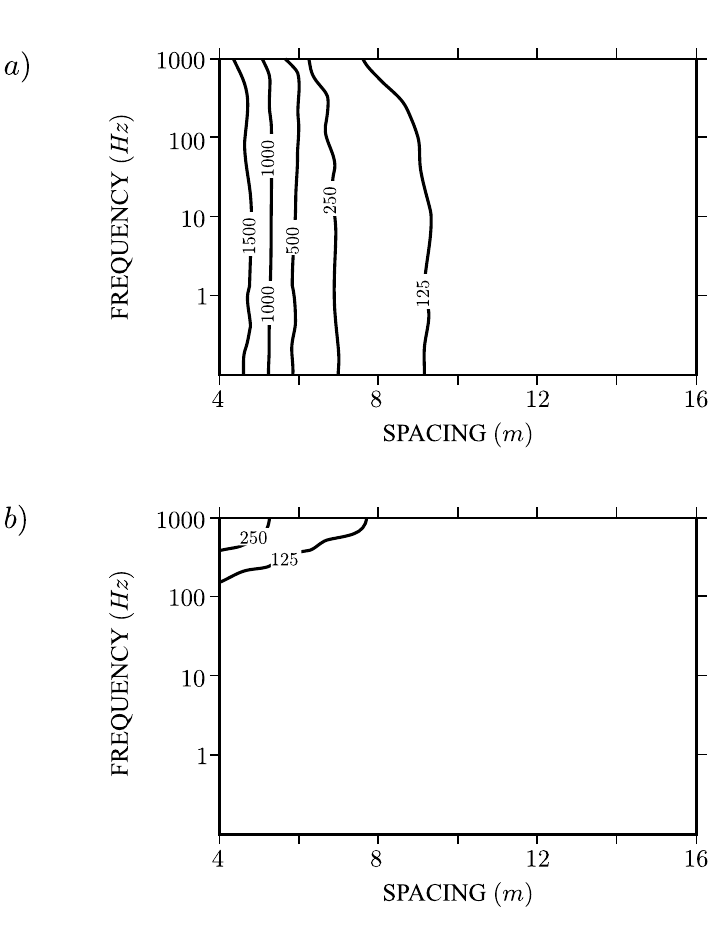
Fig. 3 – Variation of (a) the real part and (b) the imaginary part of the electric field at a depth of 7 m, in nV/m/mA, as a function of frequency and lateral spacing